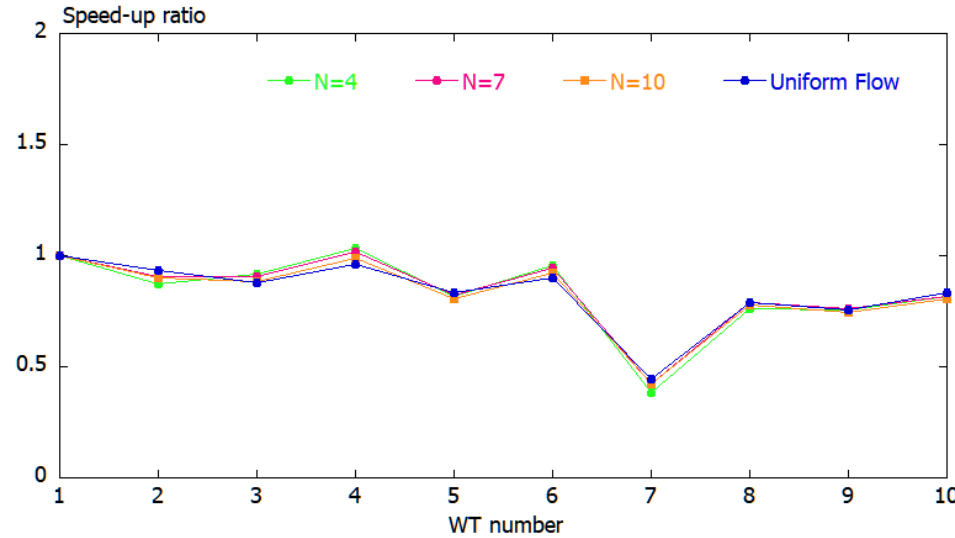
Figure 28. Comparison of local speed-up ratios obtained under various inflow shears for north- westerly wind.